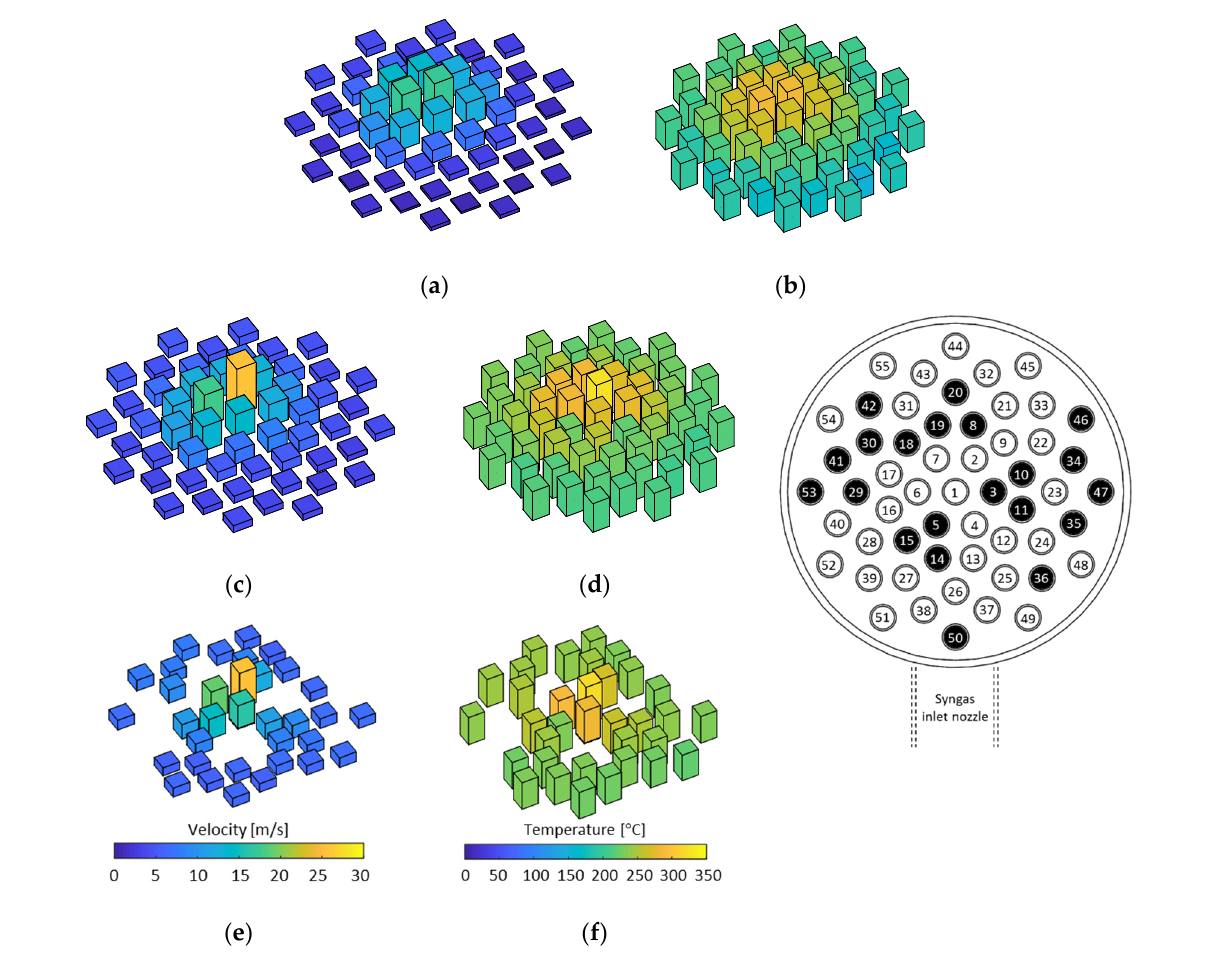
Figure 12. Syngas velocity and temperature distributions on a cross-section at the mid-length of the tube bundle for: ( a ) and ( b ) the clean heat exchanger; ( c ) and ( d ) the fouled heat exchanger; ( e ) and ( f ) the clogged heat exchanger (position of fouled/clogged tubes reported on the right by solid black color). Table 5. Heat exchanger performance for the considered configurations.